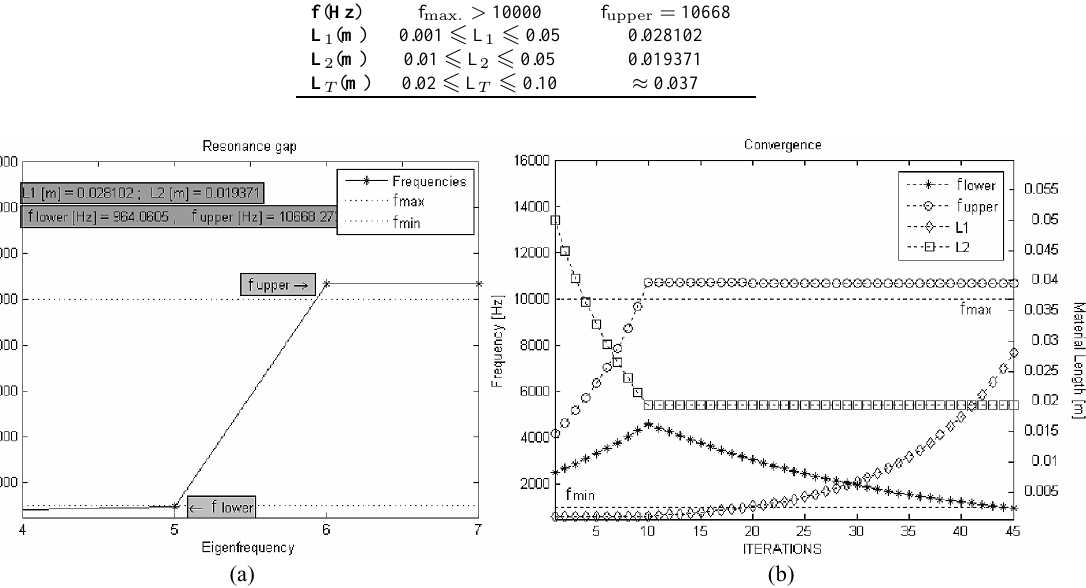
Fig. 12. Example 4: a) Resonance gap obtained; b) Frequencies and material length